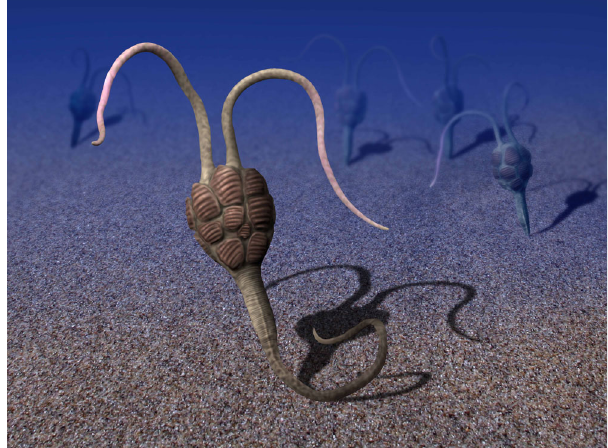
Fig. 4 Reconstruction of Yanjiahella biscarpa on the Cambrian sea fl oor. The precise arrangement of the plates on the theca is unknown. Artwork